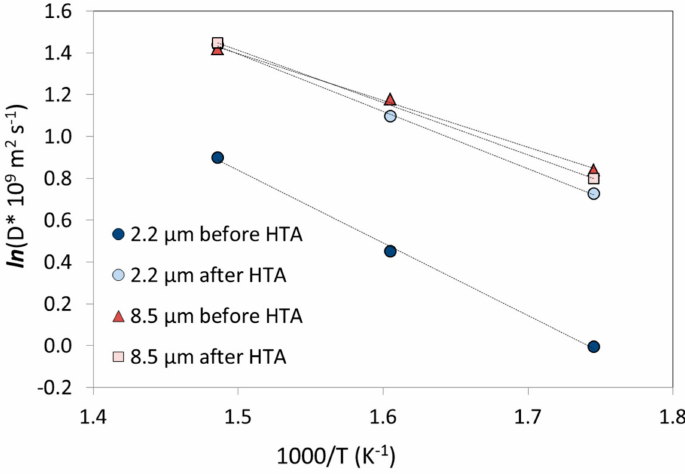
Figure 4. Arrhenius plot of the diffusivity for 2.2 µ m and 8.5 µ m thick membranes before and after HTA of both sides for the temperature range 300–400 ◦ C. The diffusivity scale is presented in logarithmic form and the dotted lines are linear